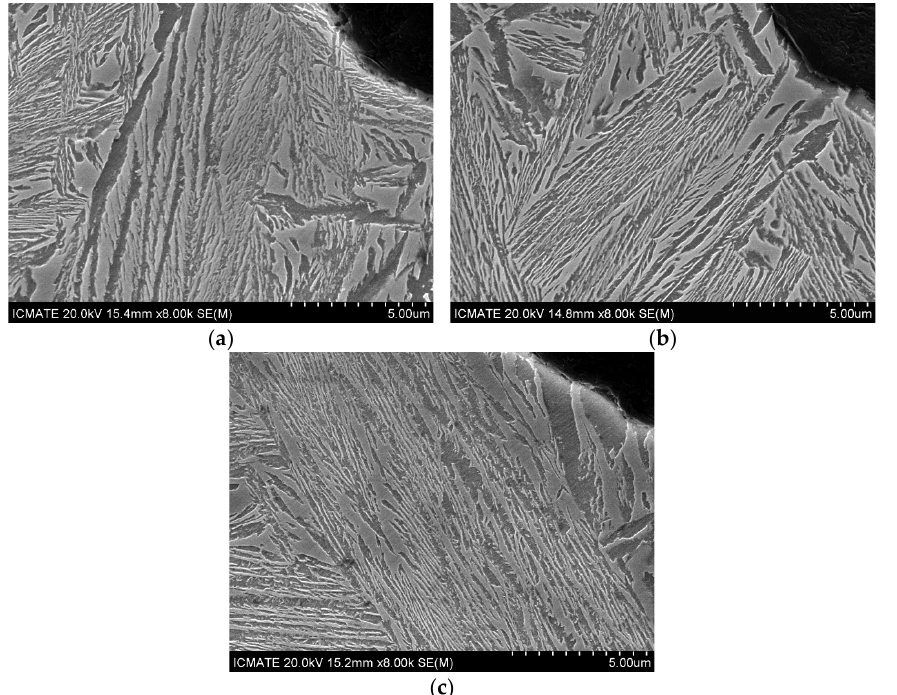
Figure 6. Selected SEM micrographs through SEI of ADIs castings with different Ni contents after austempering at 310 °C for 3 h: ( a ) 0.0 wt% 25 mm Y-blocks; ( b ) 0.7 wt% 25 mm Y-blocks and ( c ) 1.5 wt% 25 mm Y-blocks.